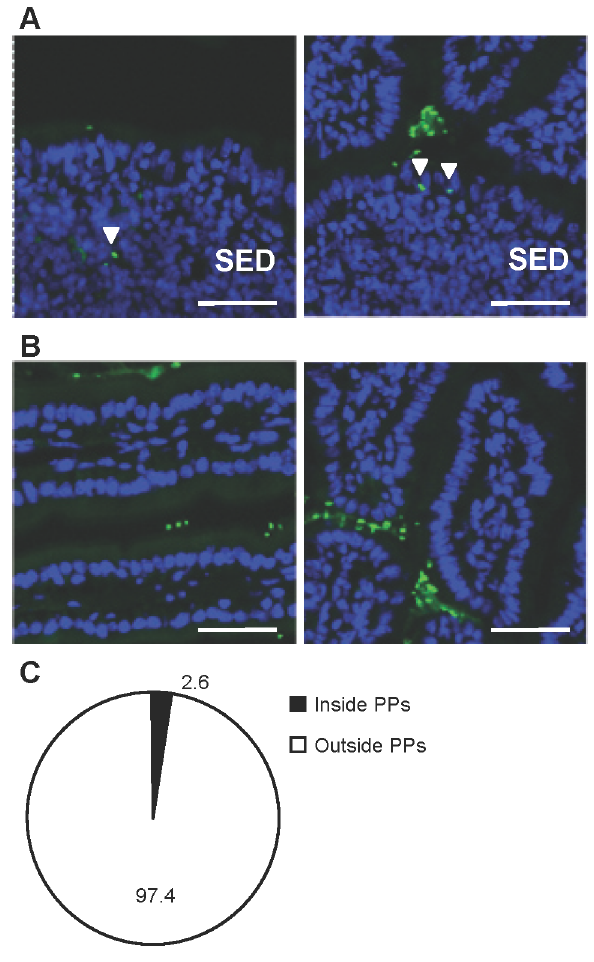
Figure 1. Localization of orally administered b240 in the small intestine. Histological analysis was performed to examine the localization of b240 in (A) the PPs and (B) the small intestine after mice were provided with autoclaved drinking water supplemented with 1 mg/ml of FITC-labeled b240 ad libitum for 3 days. Tissue sections were prepared and then stained with 4,6-diamidino-2-phenylindole (blue). b240 (green) internalized in PP are indicated by arrowheads. The bar indicates 50 m m. (C) The number of b240 inside PPs and in the luminal areas of the tissue sections was counted. Then, the proportion of b240 inside the PPs was calculated. Data are representative of 2 independent experiments producing similar results.